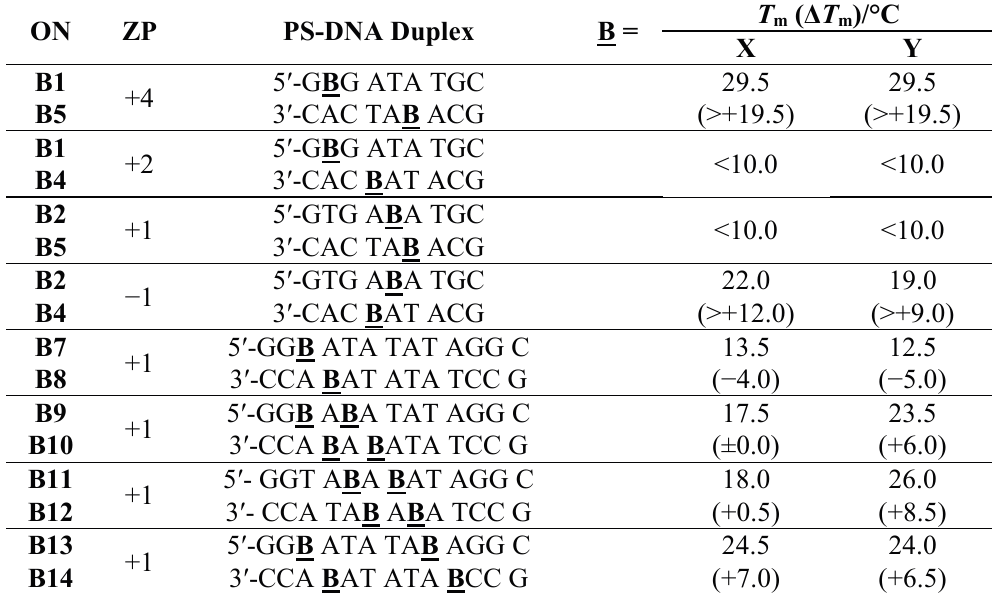
Table 2. T m and Δ T m values for PS-DNA duplexes with different interstrand zipper arrangements of X and Y monomers.